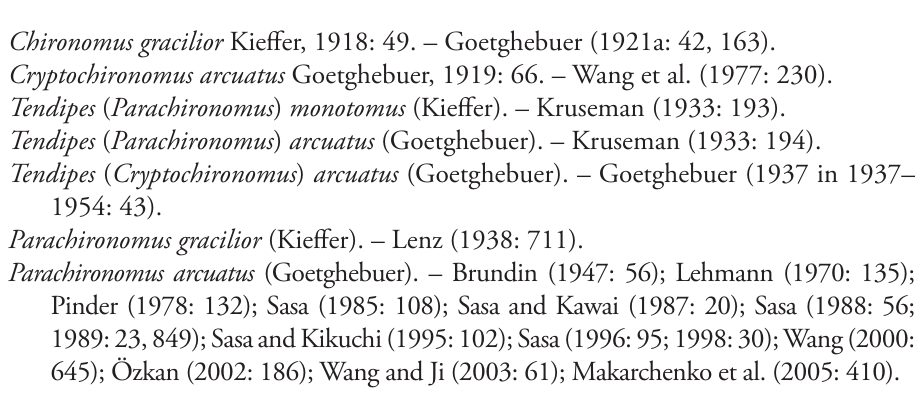
Chironomus gracilior Kieffer, 1918: 49. – Goetghebuer (1921a: 42, 163).